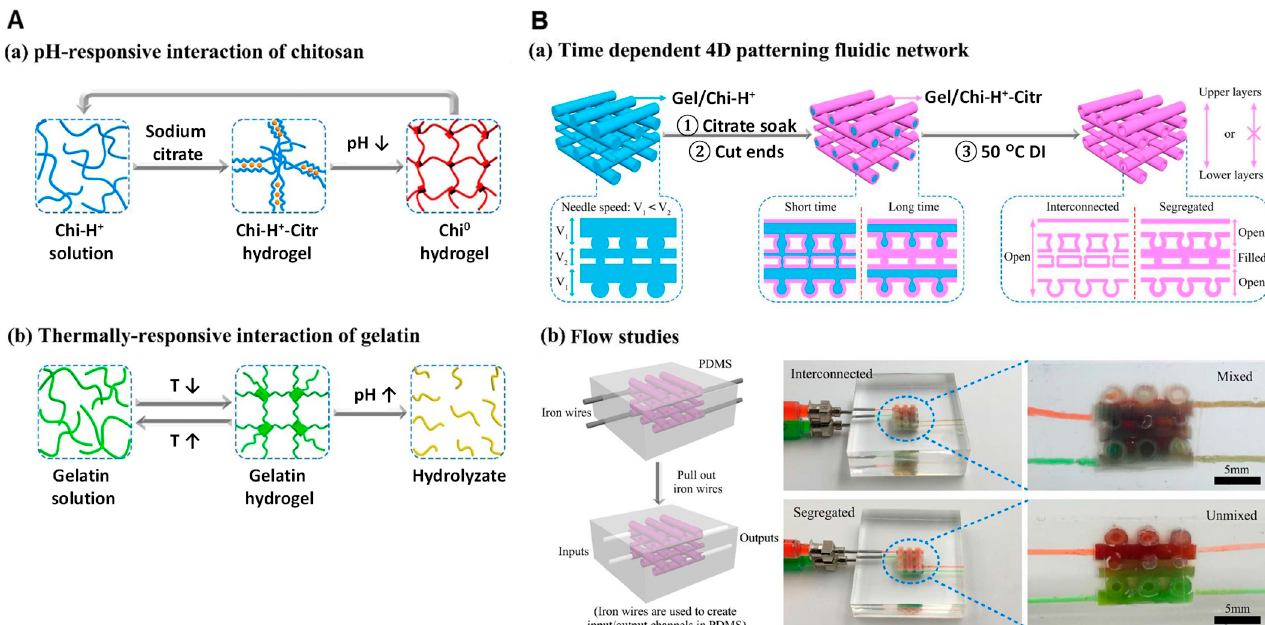
Figure 12. ( A ) Stimuli-responsive crosslinking of ( a ) chitosan and ( b ) gelatin ( B ) 4D patterning can determine whether a fluidic network is interconnected or segregated. ( a ) Schematic of the 4D pat- terning process to generate an interconnected or segregated fluidic network. ( b ) Functional evidence showing flow of the red and green input dyes is either mixed or segregated in an interconnected or segregated fluidic network. Here 4D patterned structures were embedded into PDMS in order to fix the syringe needles to avoid leakage of liquid during perfusion and clearly show the colors of liquids in each input and output. Reprinted with permission from [141], IOP Publishing.